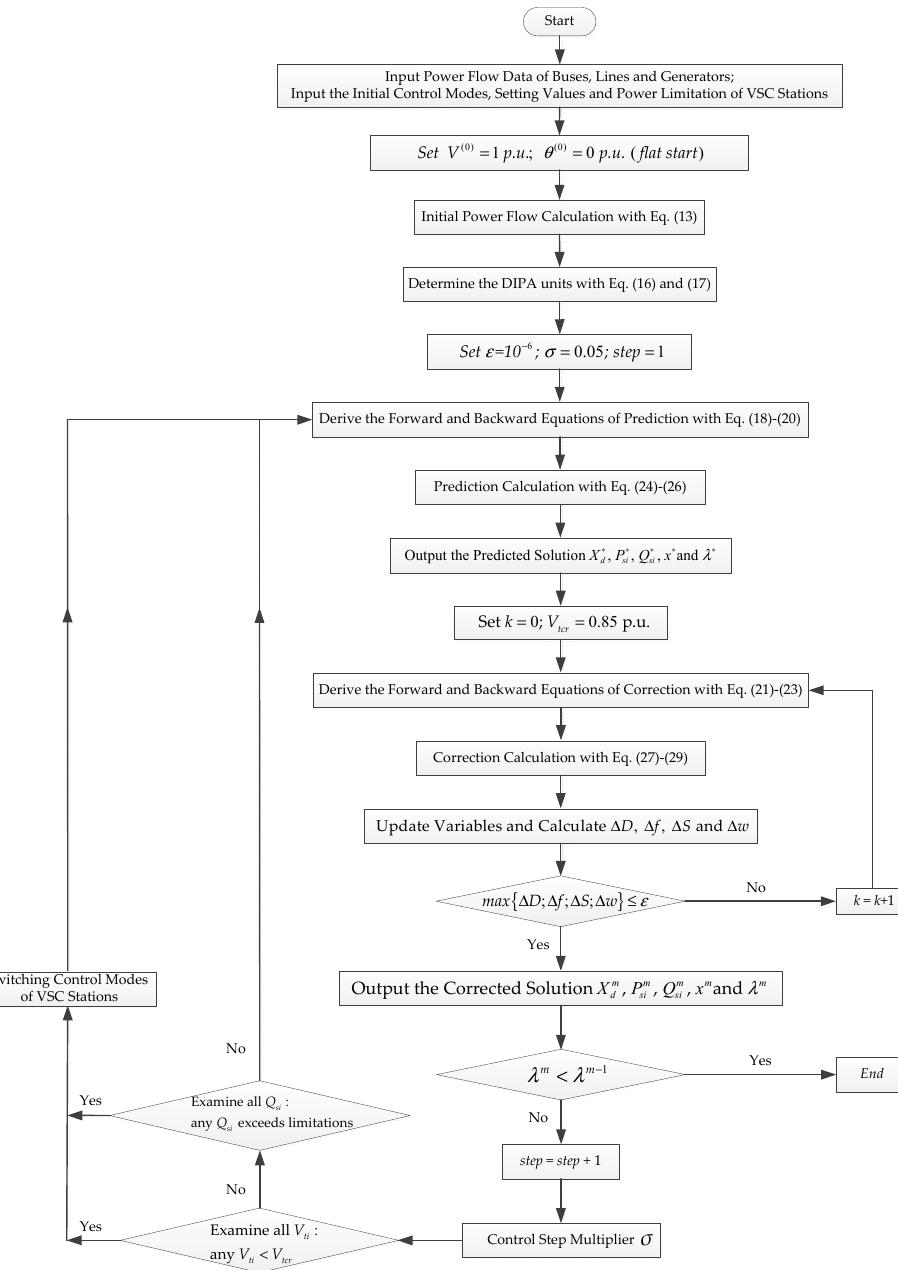
Figure 3. Calculation flow chart of CPF for M-AC/VSC-MTDC interconnected systems.